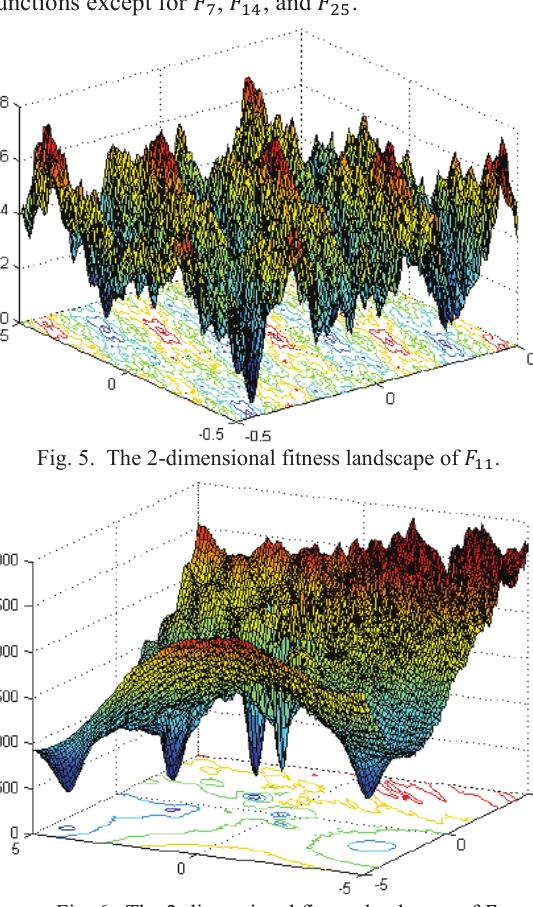
Fig. 6. The 2-dimensional fitness landscape of